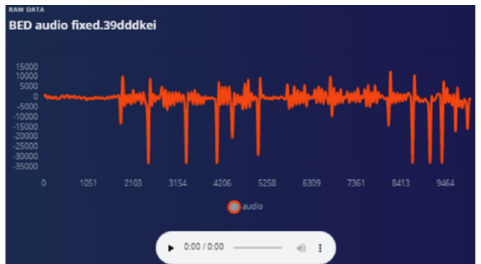
Figure 21. Response from audio when sensor fixed to a hard surface.